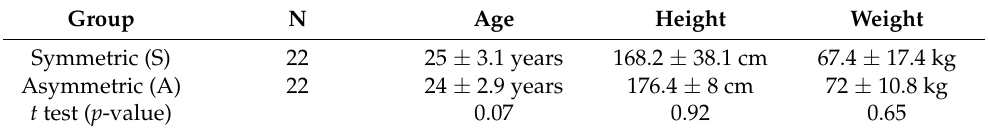
Table 1. Sample description. The data are expressed as mean ±